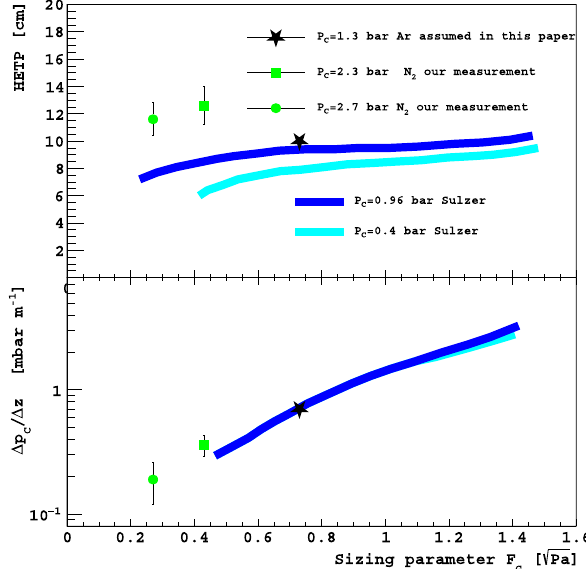
Fig. 6 Equivalent number of theoretical stages, HETP, and pressure drop per unit length, Δ p C /Δ z vs. sizing parameter F G . Blue (cyan) line:measurementswithchlorobenzene/ethylbenzenemixturesat p C = 0 . 96 bar(0.40 bar), SulzerCYGauze Packing, partialdata-setextracted from the Structured Packing brochure of Sulzer Ltd. website. The black stars correspond to the values assumed for the calculations of Aria distillation with argon in this paper, at p C = 1 . 3 bar. The full green dots (squares) correspond to the values measured during the nitrogen distillationRunA(RunB),at p C = 2 . 7 bar(2.3bar),withtheprototype column, discussed in Sect. 6, and are meant to be average values over the respective runs